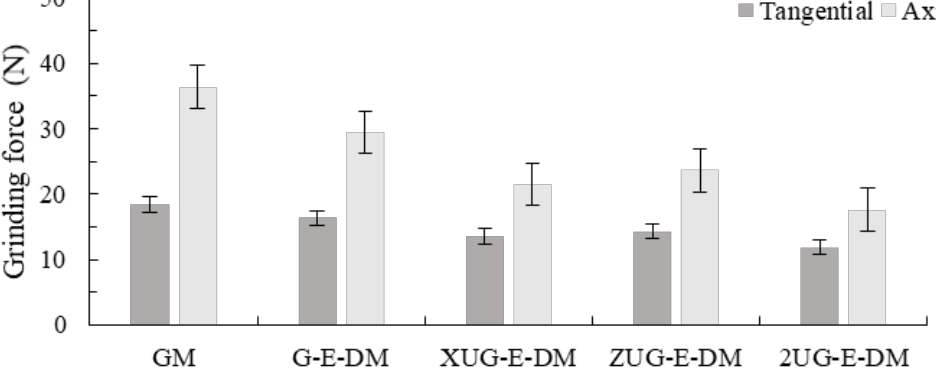
Figure 5. Grinding force in different vibration directions .